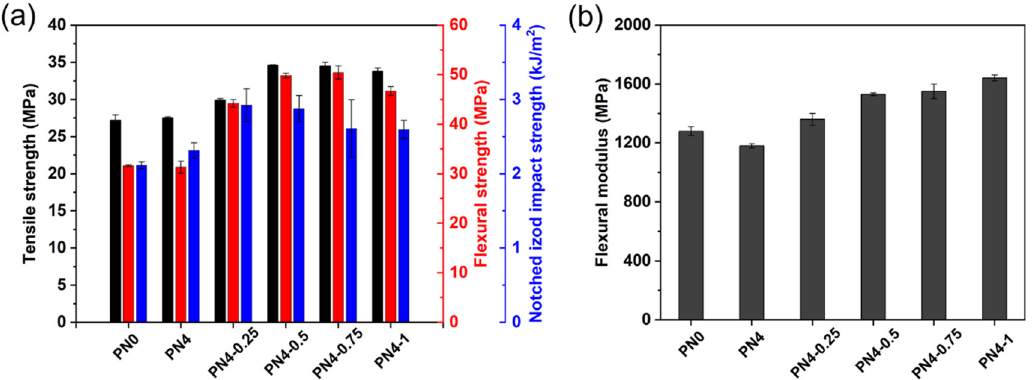
Figure 10. Mechanical properties of the PLA/PCL nanocomposites: ( a ) tensile strength, flexural strength, and notched impact strength, and ( b ) flexural modulus.